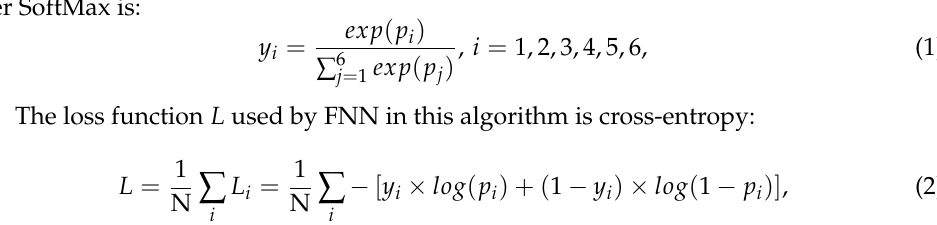
Figure 5. FNN structure of classification for depth value.